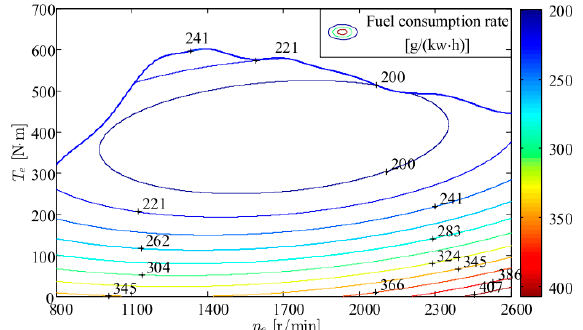
Figure 2. Engine fuel consumption map.